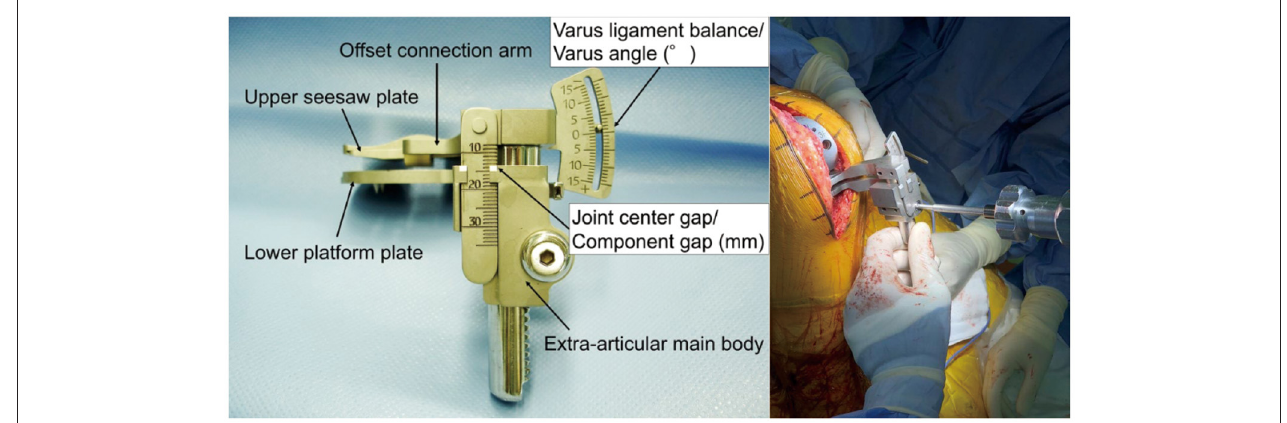
FIGURE 3 | The Offset-Repo-Tensor and the Torque Wrench.